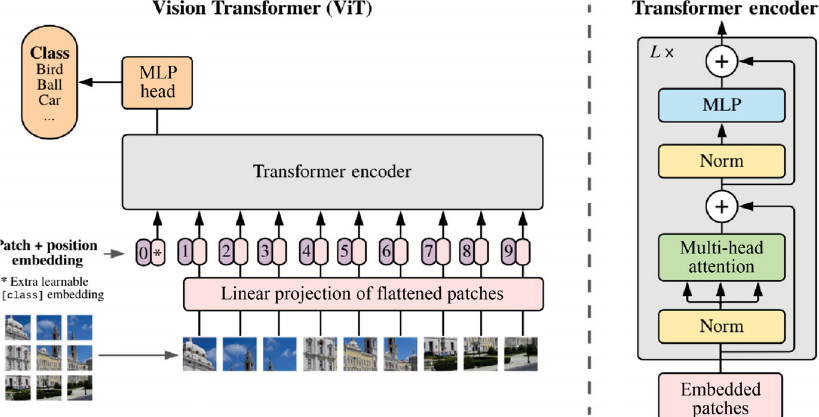
Fig. 2 Framework of ViT (left) and typical pipeline of a transformer encoder (right). Reproduced with permission from Ref. [9], c (cid:2) The Author(s)